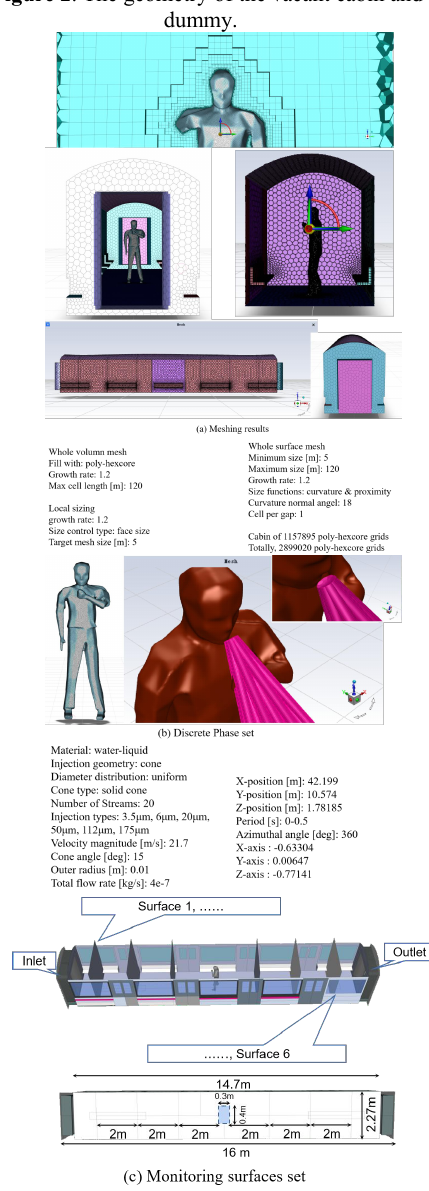
Figure 3 . The meshing results, the discrete phase set, and monitoring surfaces set of